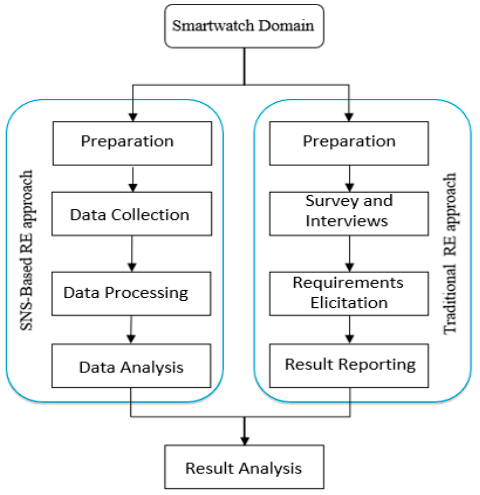
Figure 5. Experimental Process.